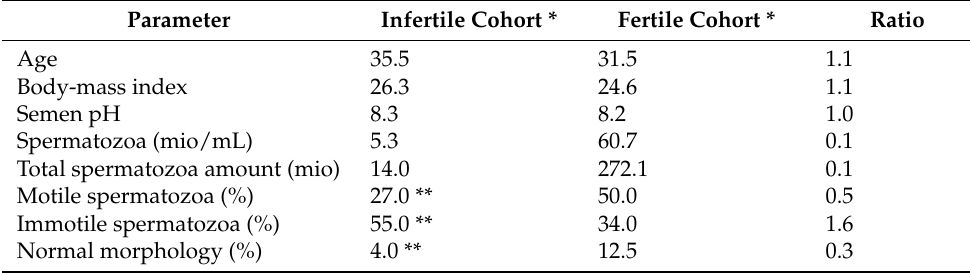
Normal morphology